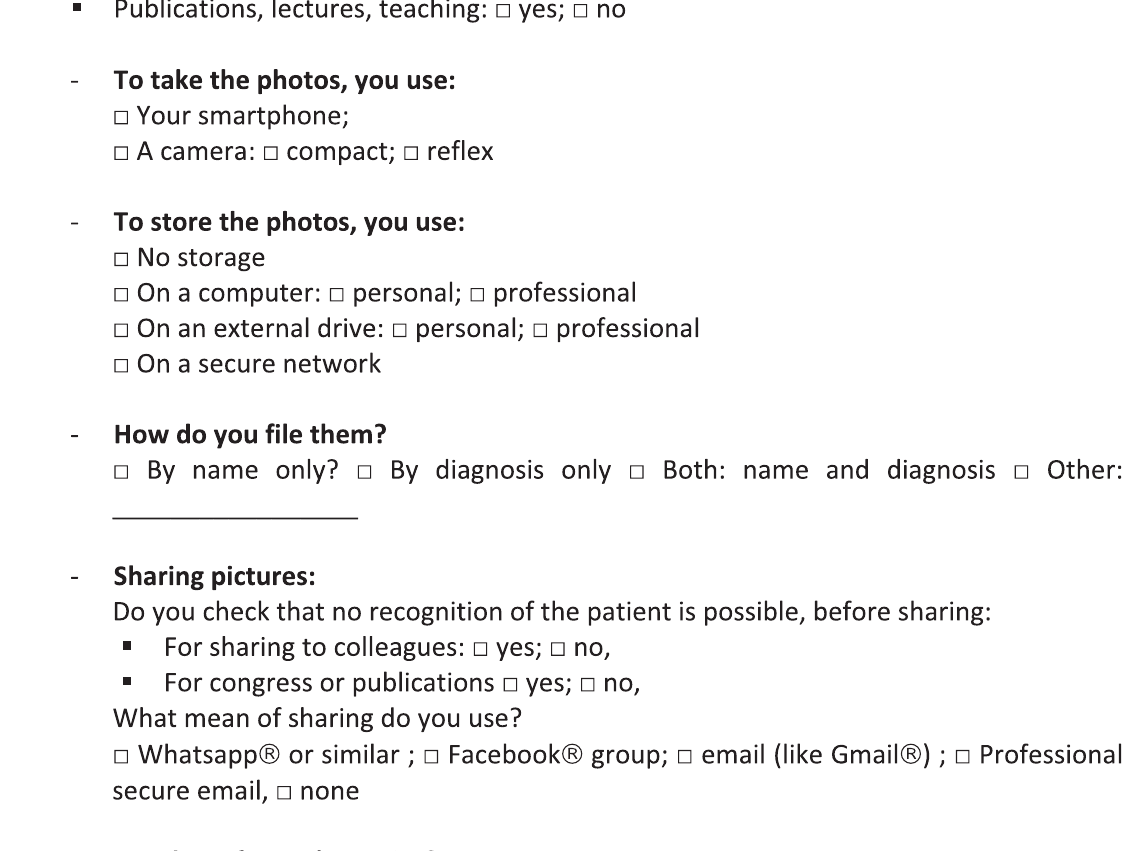
Fig. 1. Questionnaire (cid:1) Survey about the use of photography by practitioners in oral